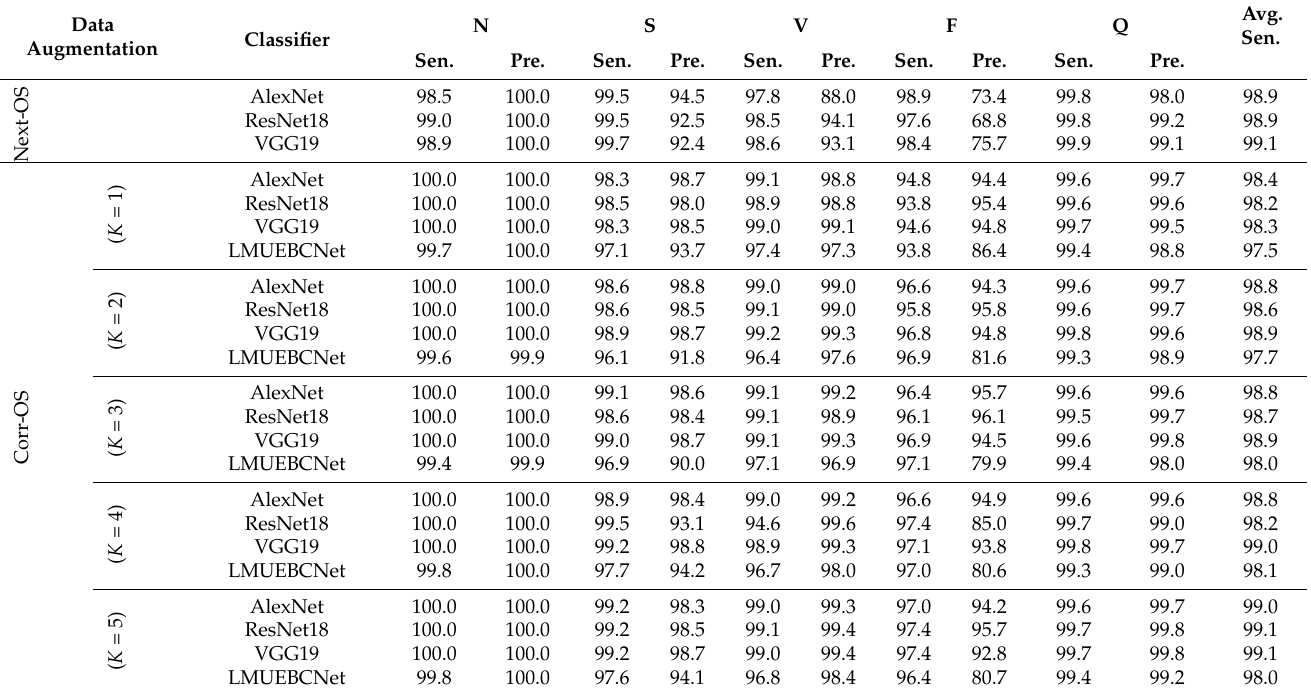
Table A3. Sensitivity/precision of LMUEBCNet with existing models using Corr-OS/Next-OS dataset under